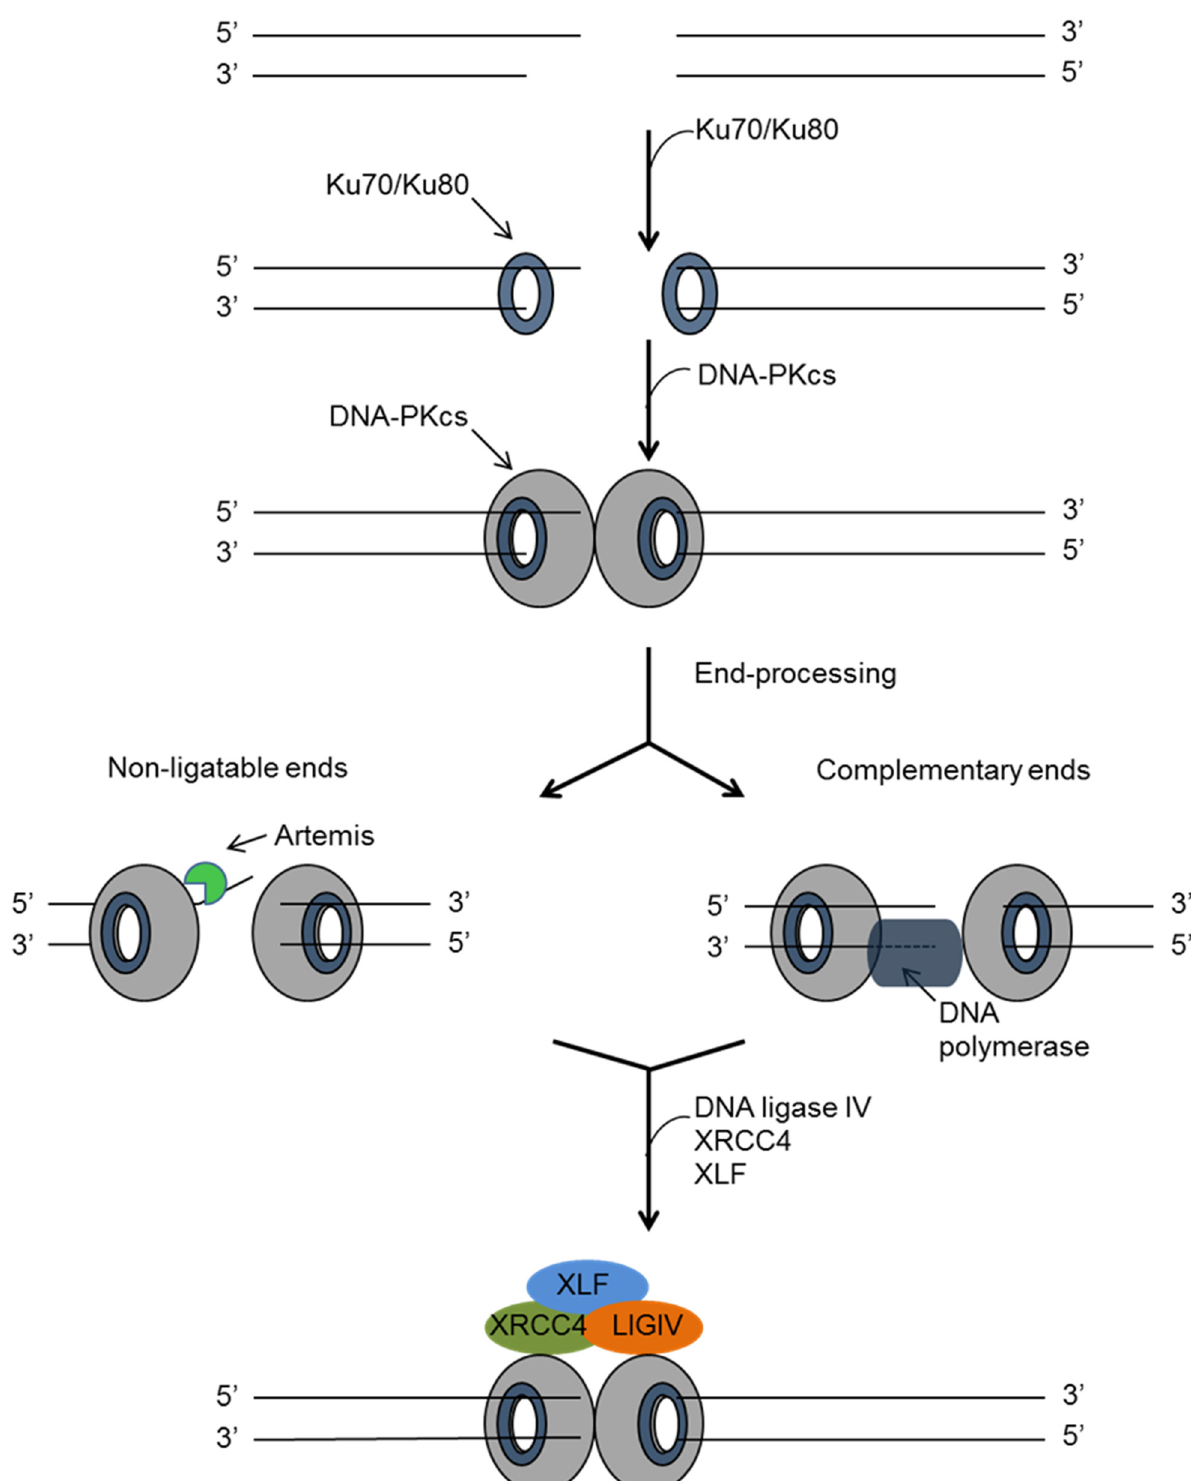
Figure 4. Non-homologous end joining repair of DSBs. Ku70/80 binds to DNA ends and provides a scaffold for the recruitment of additional proteins such as DNA-PKcs. If required, DNA ends may be cleaved by the Artemis nuclease and gaps filled by DNA polymerases. Finally, the ligation complex consisting of XLF, XRCC4 and DNA Ligase IV ligates the DNA ends to complete the